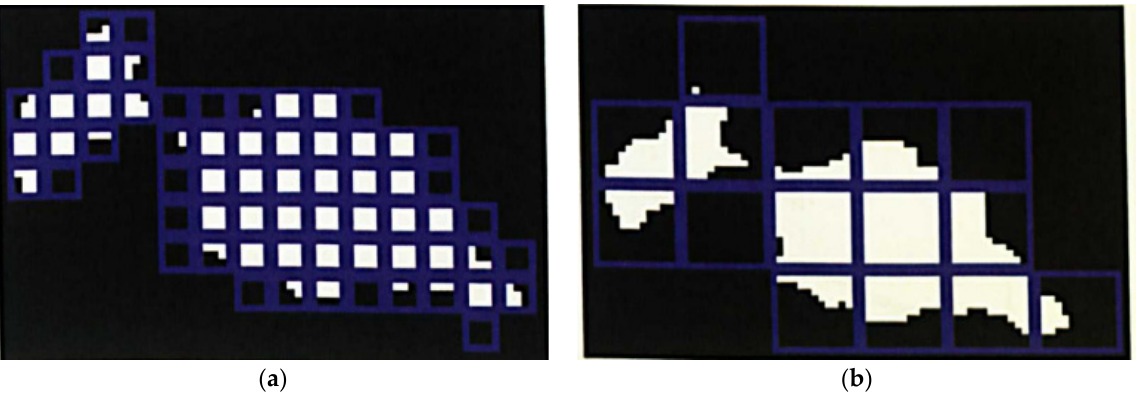
Figure 6. Example of crack analysis with different box sizes using Image-J software. ( a ) Boxing size of 1 unit ( b ) Boxing size of 4 unit